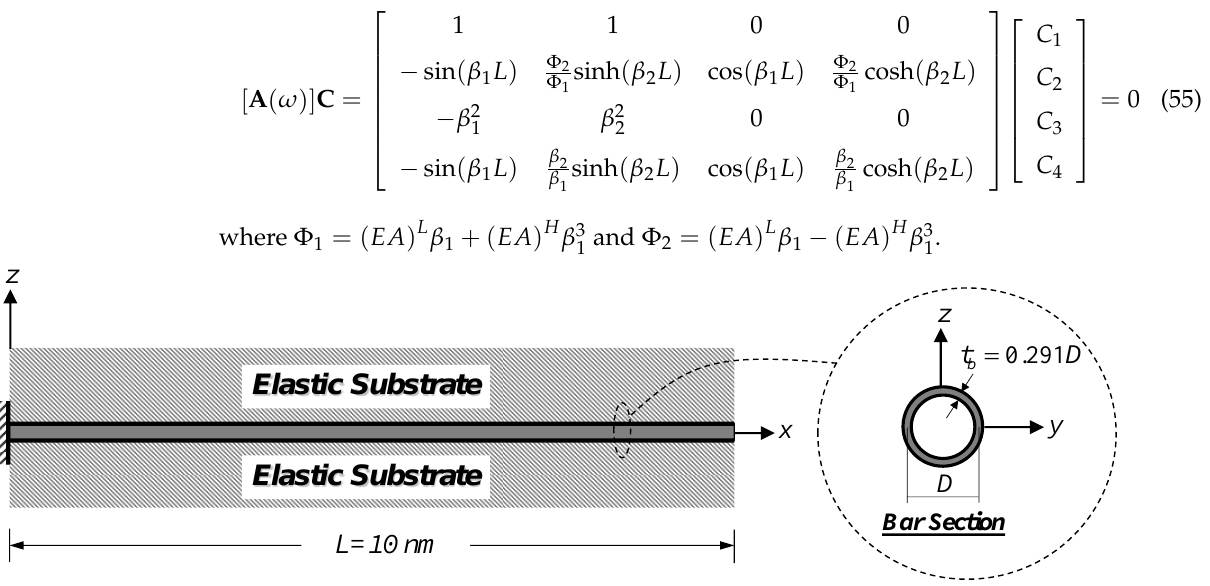
Figure 10. Cantilever SWCNT – substrate medium system: free vibration analysis.